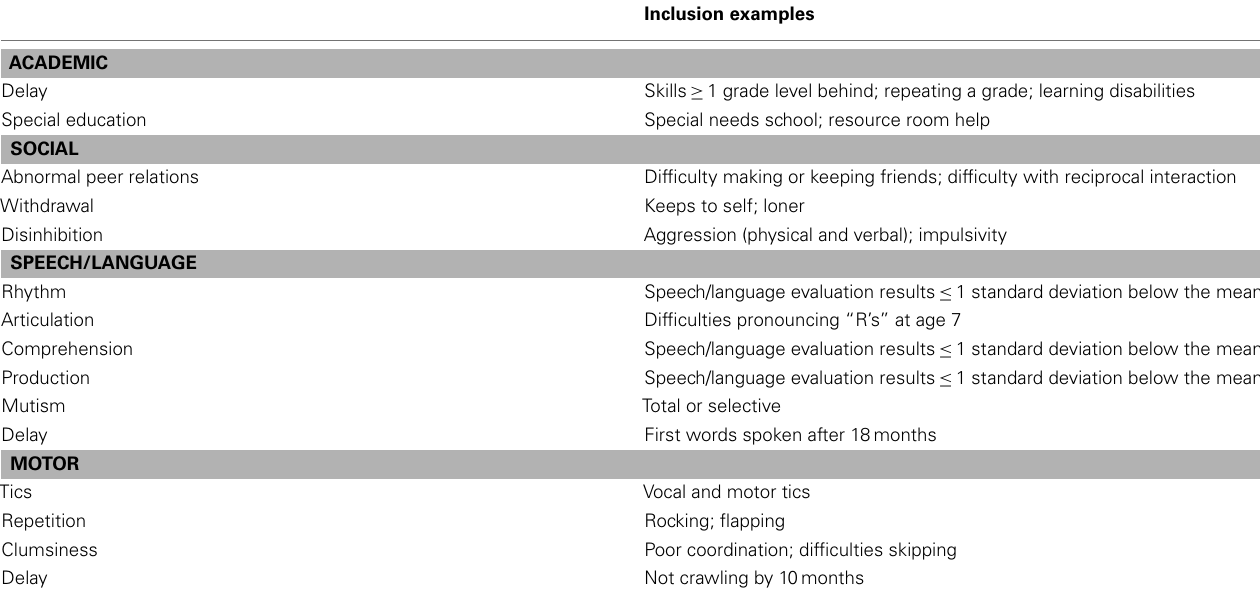
TableA2 | Fifteen item chart review for developmental issues with inclusion examples.